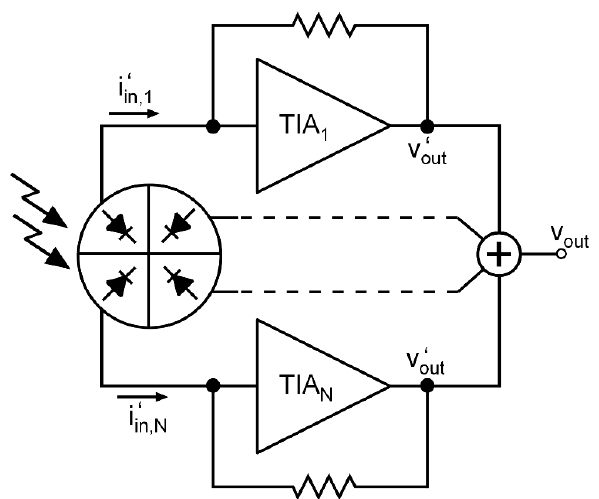
Figure 2. Conceptual scheme of a photodiode read-out using the sliced- photodiode (PD) technique with N TIAs.